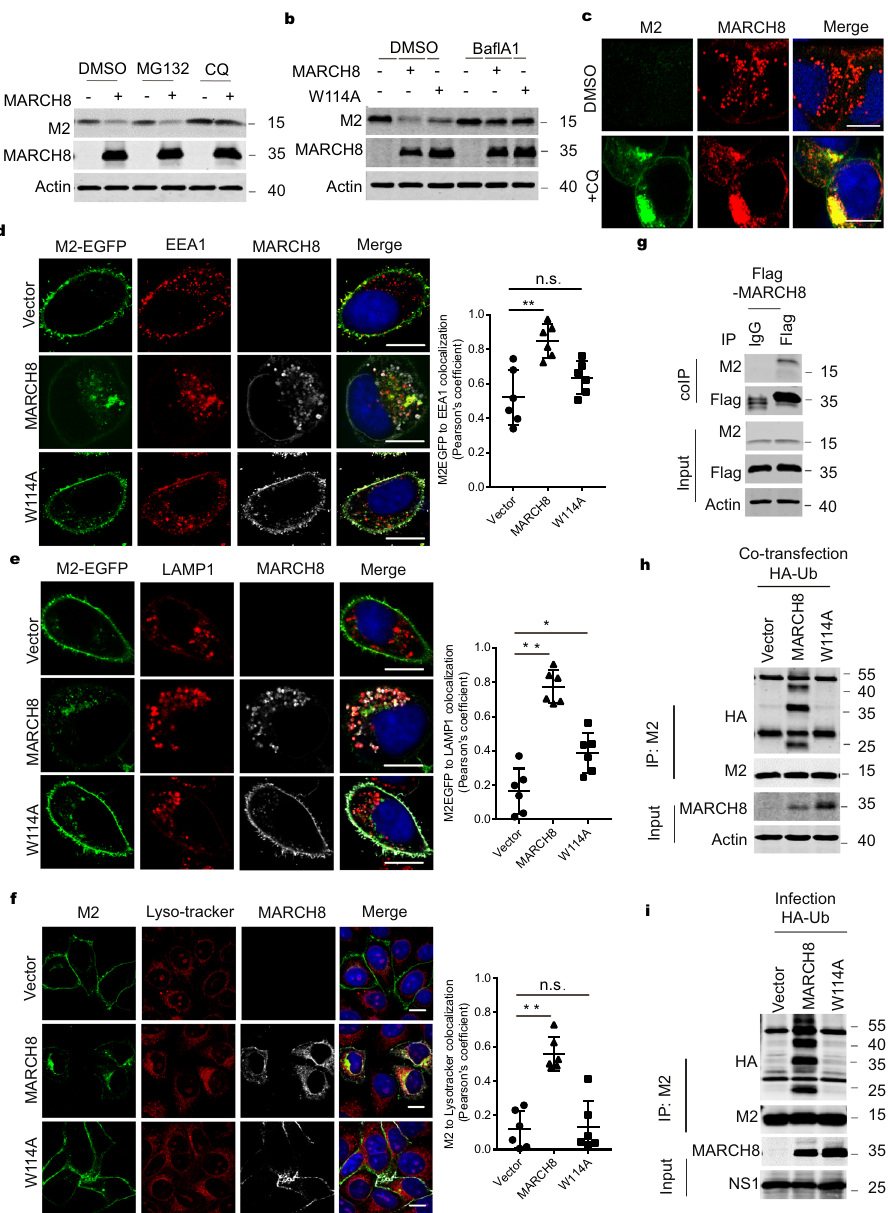
Fig. 5 MARCH8 ubiquitinates and leads to M2 degradation in lysosomes. a , b Rescue of M2 expression from MARCH8-induced degradation by lysosome inhibitors. HeLa cells were co-transfected with the M2 plus Vector ( − ), MARCH8 ( + ), or W114A ( + ). Cells were treated with DMSO, lysosomal inhibitor chloroquine (CQ, 50 μ m) or proteasome inhibitor MG132 (25 μ m) ( a ), DMSO or a vacuolar H + translocating ATPase inhibitor (Balf A1, 100nM) ( b ), followed by western blot. c HeLa cells co-transfected with M2 and MARCH8 plasmid were treated with DMSO or CQ and processed for immuno fl uorescence staining with anti-M2 (green) and anti-MARCH8 antibodies (red). Scale bars represent 10 μ m. d , e HeLa cells transfected with EGFP fused M2 and vector, MARCH8 or W114A were permeabilized, then co-stained with MARCH8 (white) and EEA1 (red) antibodies ( d ) or with MARCH8 (white) and LAMP1 (red) antibodies ( e ). Scale bars represent 10 μ m. f HeLa cells were co-transfected with M2 plus Vector, MARCH8 or W114A. The lyso-Tracker (red) was added to cells 30min before fi xation. M2 (green) and MARCH8 (white) were detected by immunostaining. Scale bars represent 10 µ m. Pearson ’ s correlation coef fi cient analysis was based on multiple sight fi elds each group ( n = 6 fi elds). * P <0.01; ** P <0.001; n.s., nonsigni fi cant, unpaired two-tailed Student t -test. g Co-immunoprecipitation of M2 and Flag-MARCH8 in HEK293T cells. h , i MARCH8 ubiquitinates IAV M2. HEK293T cells were transfected with HA-Ub, M2 and Vector, MARCH8 or W114A ( h ). HEK293T cells transfected with HA-Ub and Vector, MARCH8 or W114A were infected with WSN virus (MOI = 2) for 12h ( i ). Whole-cell lysates were subjected to IP with anti-M2 antibody, and the IP and input were analyzed by western blotting with antibodies against the indicated targets. (47.7 PFU) than for WT virus (204.1 PFU) (Supplementary Table 1), with the high pathogenicity, much higher titers of K78R IAV were indicating a marked increase of virulence due to the K78R mutation detected in the lungs of the infected mice compared to those of the in M2. At the dose of 200 PFU, K78R IAV-infected mice lost weight wild-type IAV (Fig. 7d). Histopathological assessment of lungs from more quickly than the wild-type IAV (Fig. 7b), and all of the K78R the infected mice showed that K78R IAV caused more serious IAV-infected mice had to be euthanized by day 8, whereas only bronchiolitis and bronchitis and lumen debris accumulation by 40% of the WT virus-infected mice succumbed (Fig. 7c). Associated 3 days post infection. By day 6, mice infected with K78R virus all NATURE COMMUNICATIONS| (2021) 12:4427